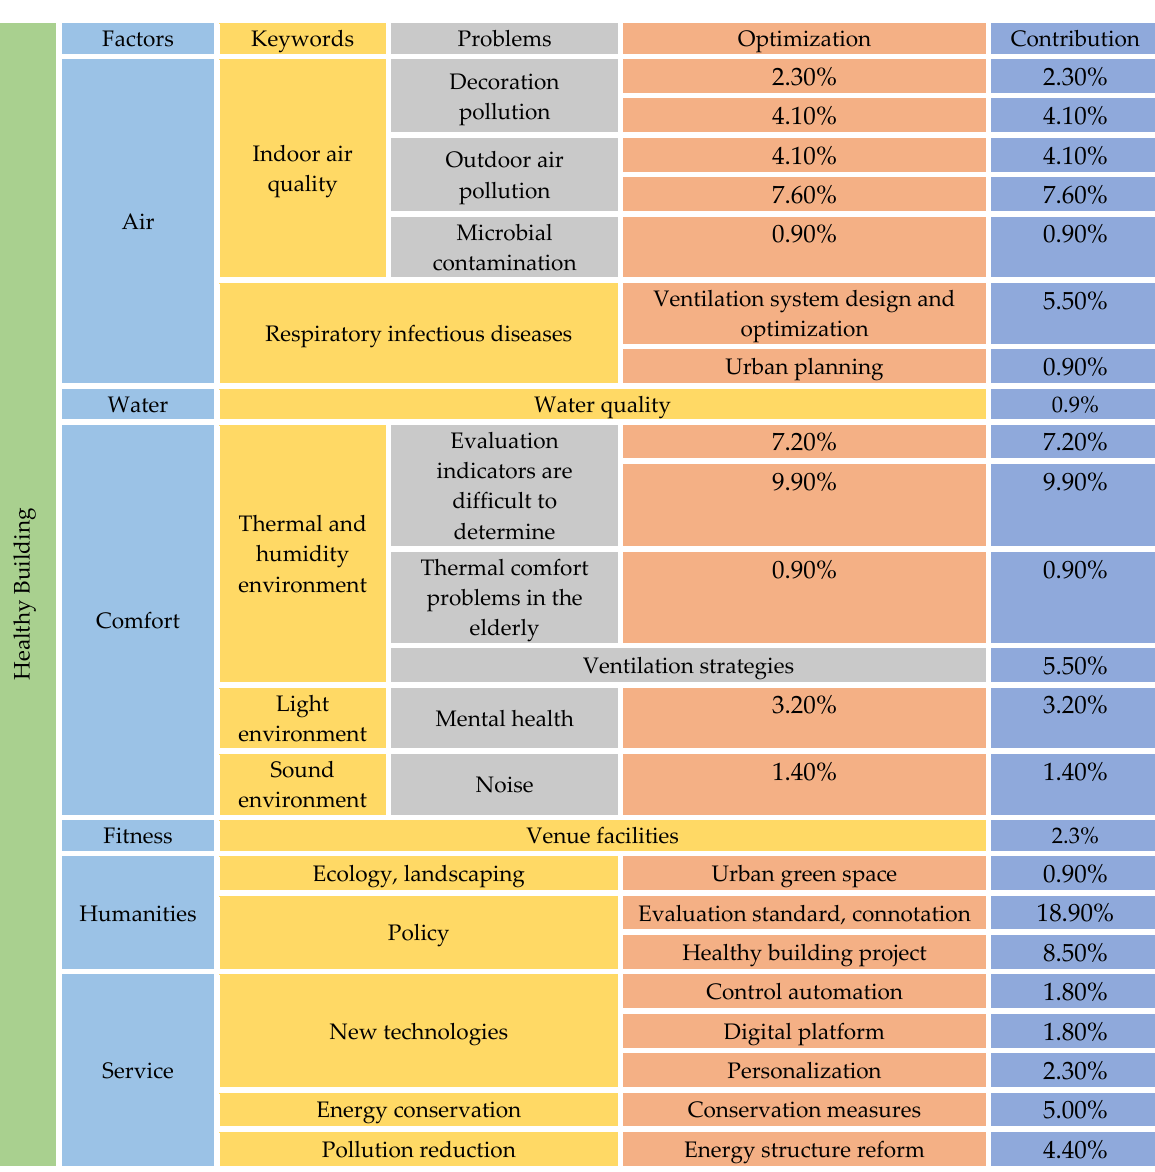
Figure 3. Contributions of literature on healthy building in China.